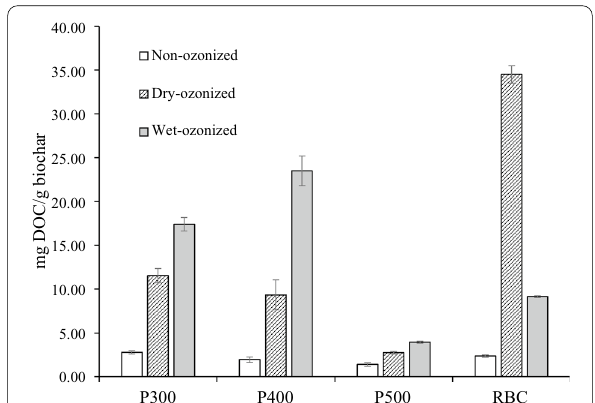
Fig. 1 Total dissolved organic carbon extracted from the pine 300 (P300), pine 400 (P400), pine 500 (P500), and rogue biochar (RBC) before and after wet/dry ozonization. The DOC amounts reported are in mg DOC/g biochar. The error bars denote the error of the average of 3 measurements ( n =